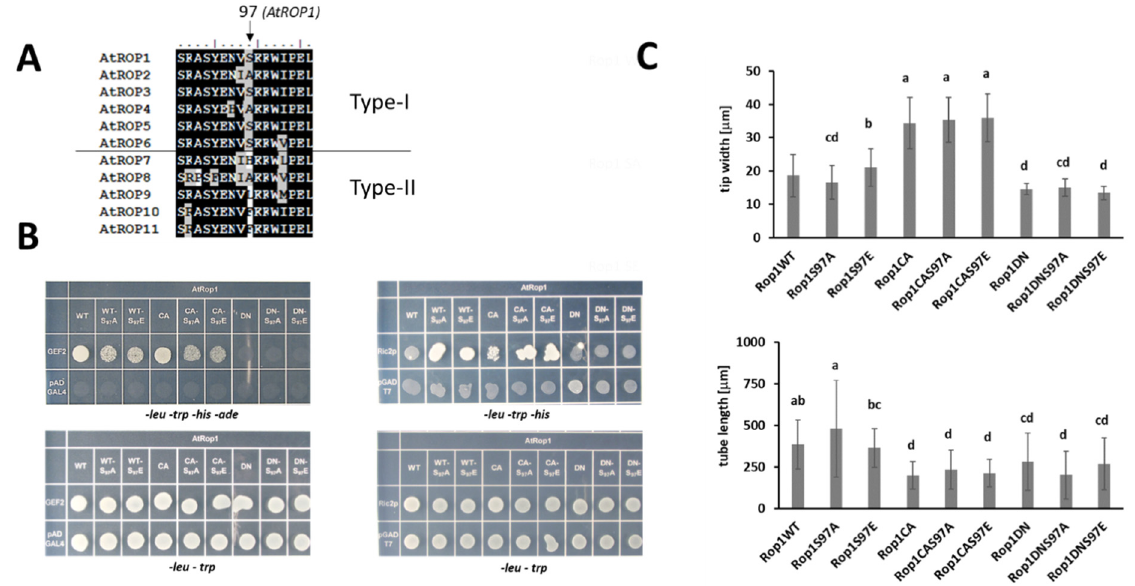
Figure 6. Effect of the S97A or S97E mutations on ROP1 function. ( A ) The S97 residue is conserved only in four Type-I ROPs. ( B ) Both mutations similarly affect the interaction of ROP1with GEF2 or RIC2 in the yeast two-hybrid system (leu- trp-selection for positive transformation; his- ade- selection for interaction). ( C ) Effect of the transient expression of wild- type and mutant YFP-fused ROP1 versions driven by the Lat52 pollen-specific promoter on the growth of tobacco pollen tubes. Tip width and tube length were measured for 20–20 fluorescent pollen tubes. Averages and standard deviations are shown. Different letters mean statistically significant difference ( p < 0.05; one-way analysis of variance (ANOVA) following Duncan’s multiple range tests). WT—wild type; CA—constitutive active; DN—dominant negative.